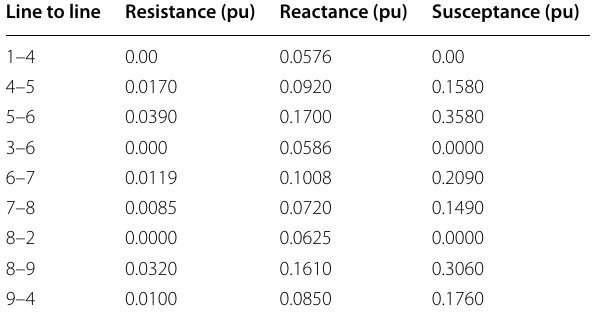
Table 1 Line parameter of standard IEEE test 9 bus